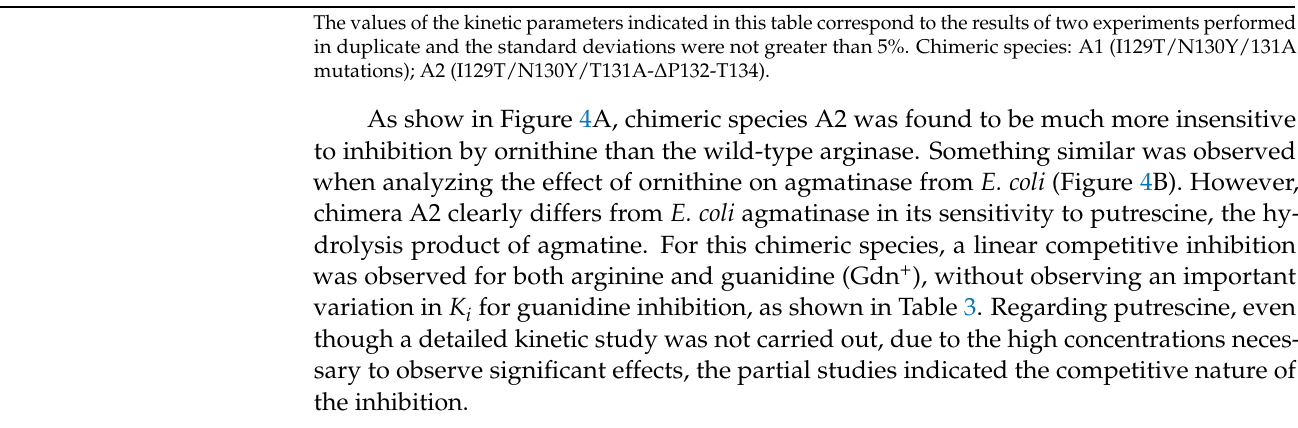
Figure 4. Inhibition of chimeric species A2 ( ● ), wild type arginase ( ○ ) and agmatinase of E. coli ( ∆ ) by ornithine ( A ) and putrescine ( B ), at pH 9.5. The enzymatic activities were measured at 37 °C, with